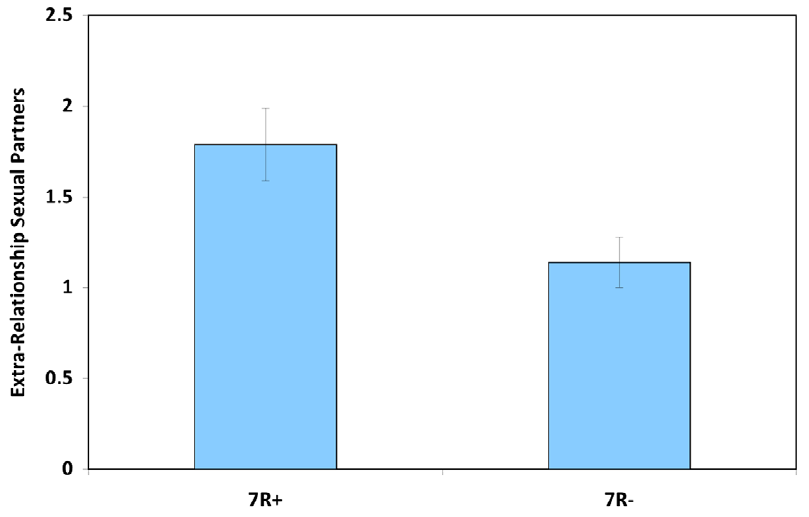
Figure 3. Number of extra-relationship sexual partners, by DRD4 genotype group.